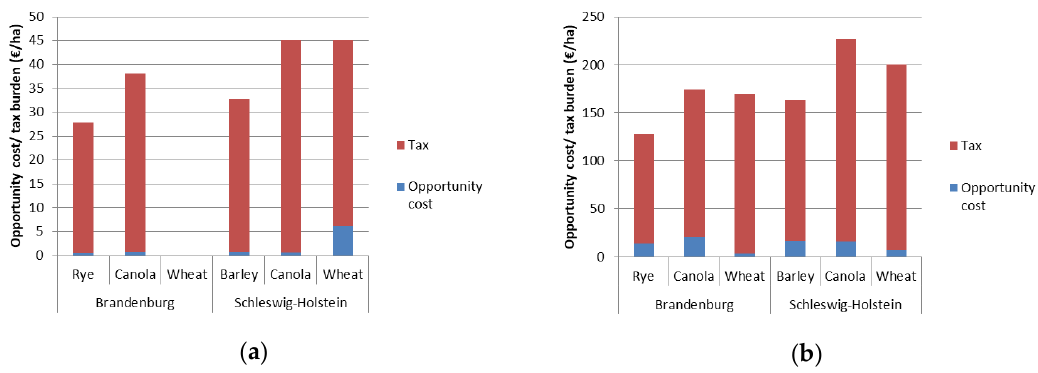
Figure 2. Effect of a 0.20 € ( a ) and 1.00 € ( b ) tax on N fertilizer use on net opportunity cost and tax burden (risk neutral farmer), based on field experiments in Brandenburg and Schleswig-Holstein.